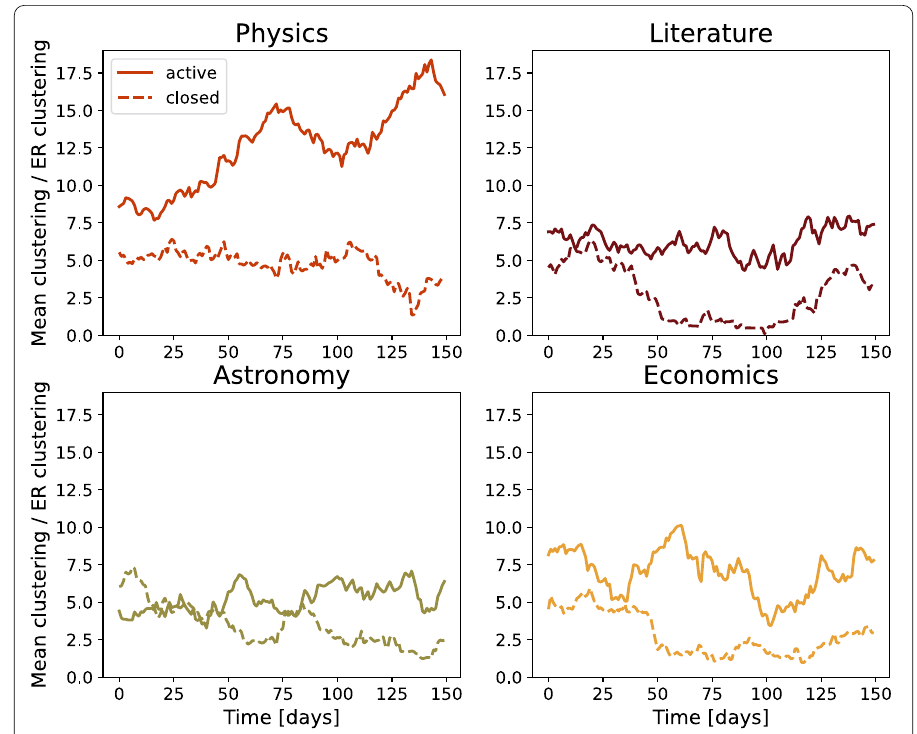
Figure 3 Normalized mean clustering coefficient of 30 days sub-networks for four pairs of Stack Exchange websites: Astronomy, Literature, Economics, and Physics. Solid lines – active sites; dashed lines – closed sites